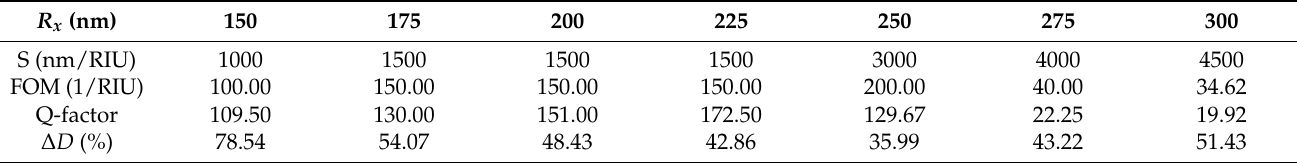
Table 3. The S, FOM, Q-factor, and ∆ D of case 4 with different R for mode